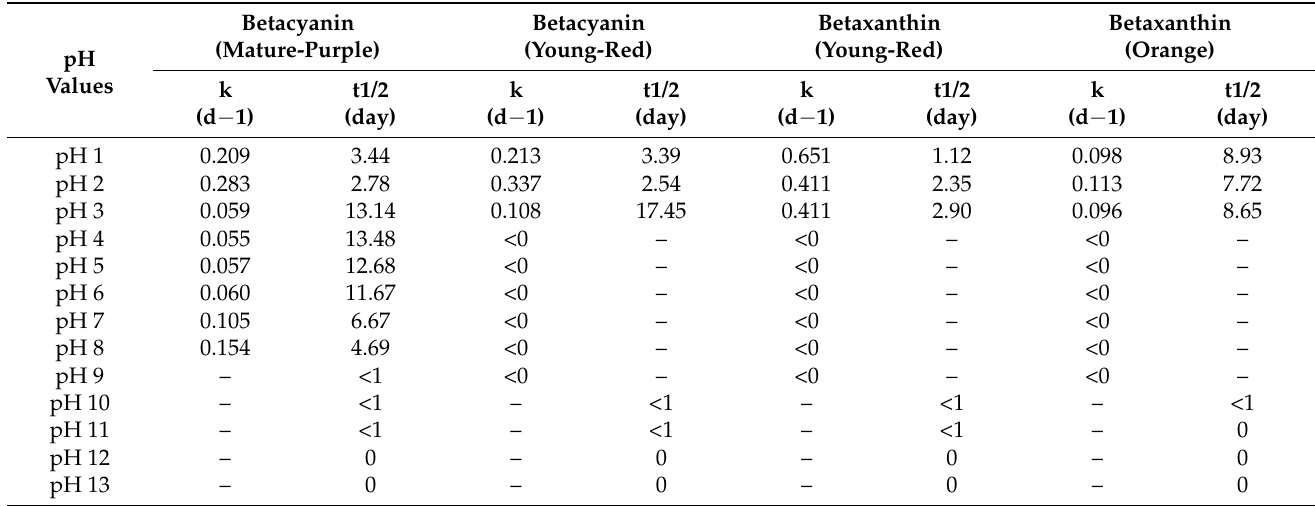
Table 1. Kinetic parameters of thermal degradation for BBEs at different